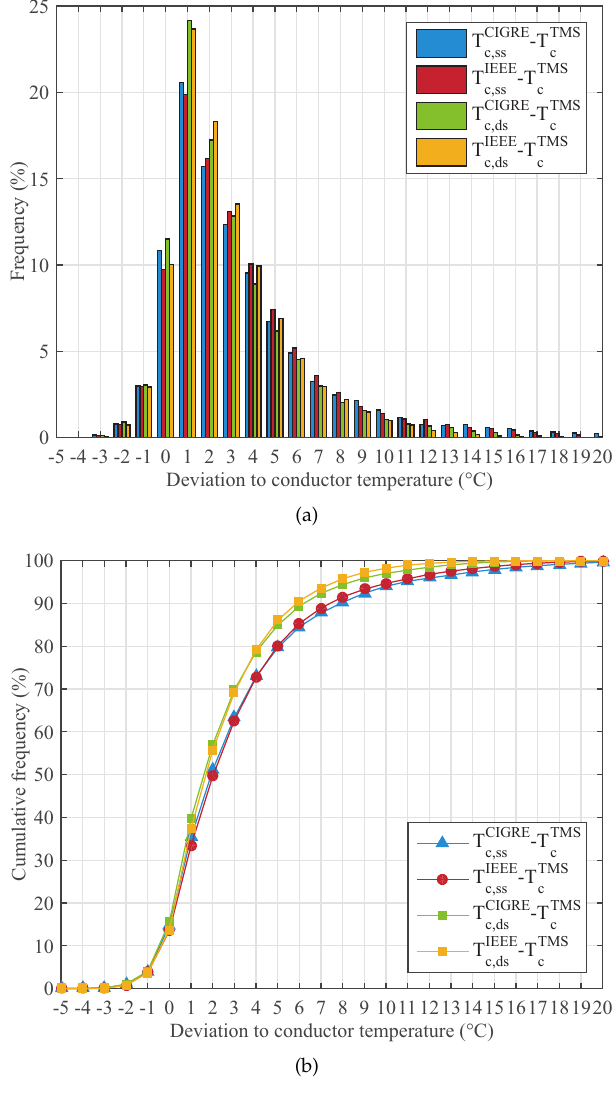
Figure 3. Frequency and cumulative frequency of differences between temperatures obtained using ) standards and the measured conductor CIGRE ( T CIGRE c , ss and T CIGRE ) and IEEE ( T IEEE c , ss and T IEEE c , ds c , ds temperature ( T TMS c ) for an entire year. ( a ) Frequency; ( b ) Cumulative